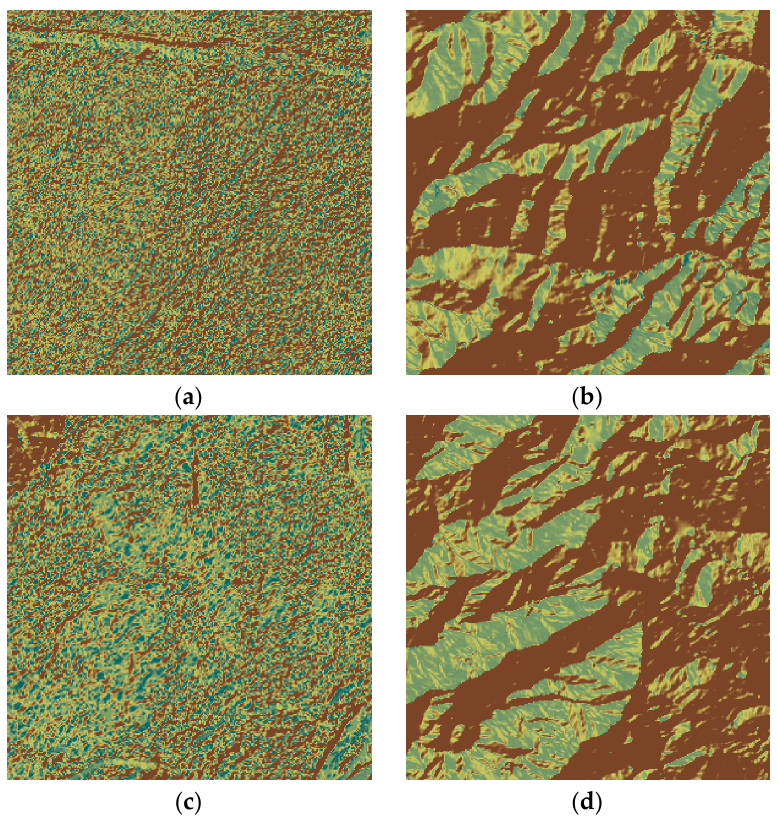
Figure 12. ( a ) A flat area in the test area within the training area; ( b ) A mountainous area in the test area within the training area; ( c ) A flat area in the test area outside the training area; ( d ) A moun ‐ tainous area in the test area outside the training area. Table 9. Values of RMSE for different super ‐ resolution reconstruction methods in flat areas and mountainous areas of test datasets from the training region and outside the training region, respec ‐ tively.